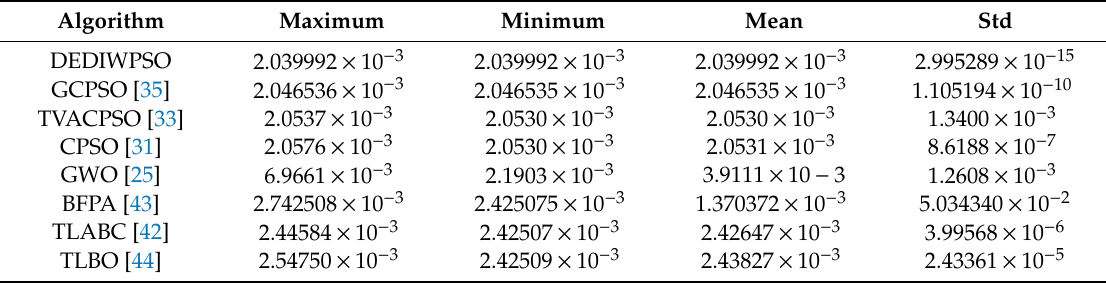
Table 8. Comparsion of the obtained RMSE for the single-diode